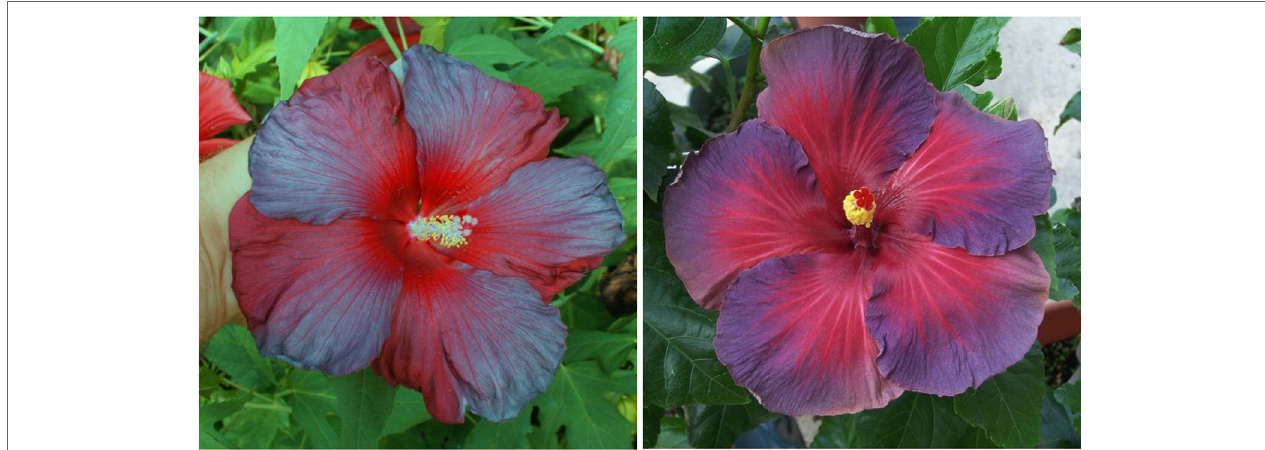
FIGURe 3 | Flower color of H. x moscheutos hybrid “TAMUS-4614” (left) and H. rosa-sinensis “Nightfire” (right). Photo credits: Dariusz P. Malinowski (“TAMUS- 4614”) and Naralin Valanna (“Nightfire”), https://i.pinimg.com/originals/45/49/4b/45494bf39000d95df552c27d01049017.jpg.